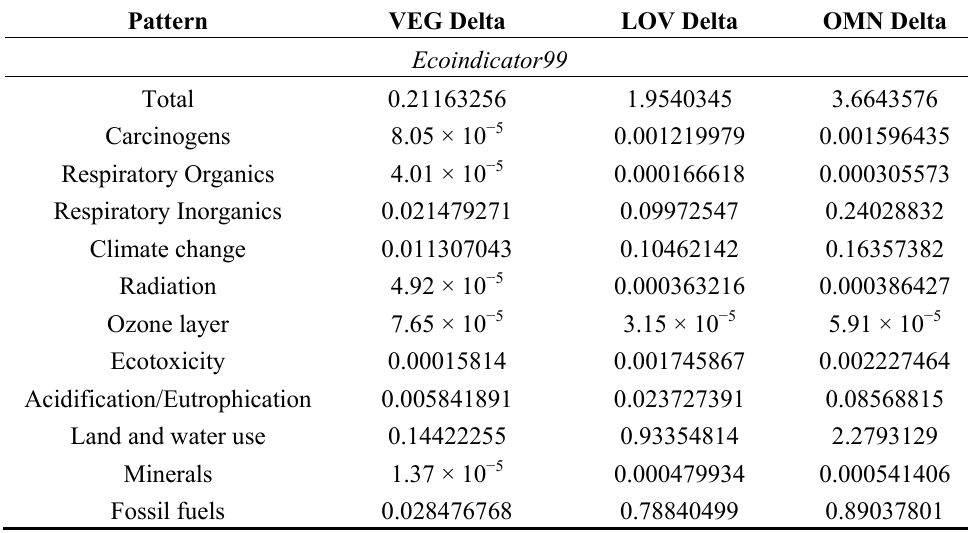
Table 2. Delta study: total and partial environmental impacts (indicated as single score, Pt per week) of the 19% component in which the three 2400 kcal patterns differ (delta), according to each